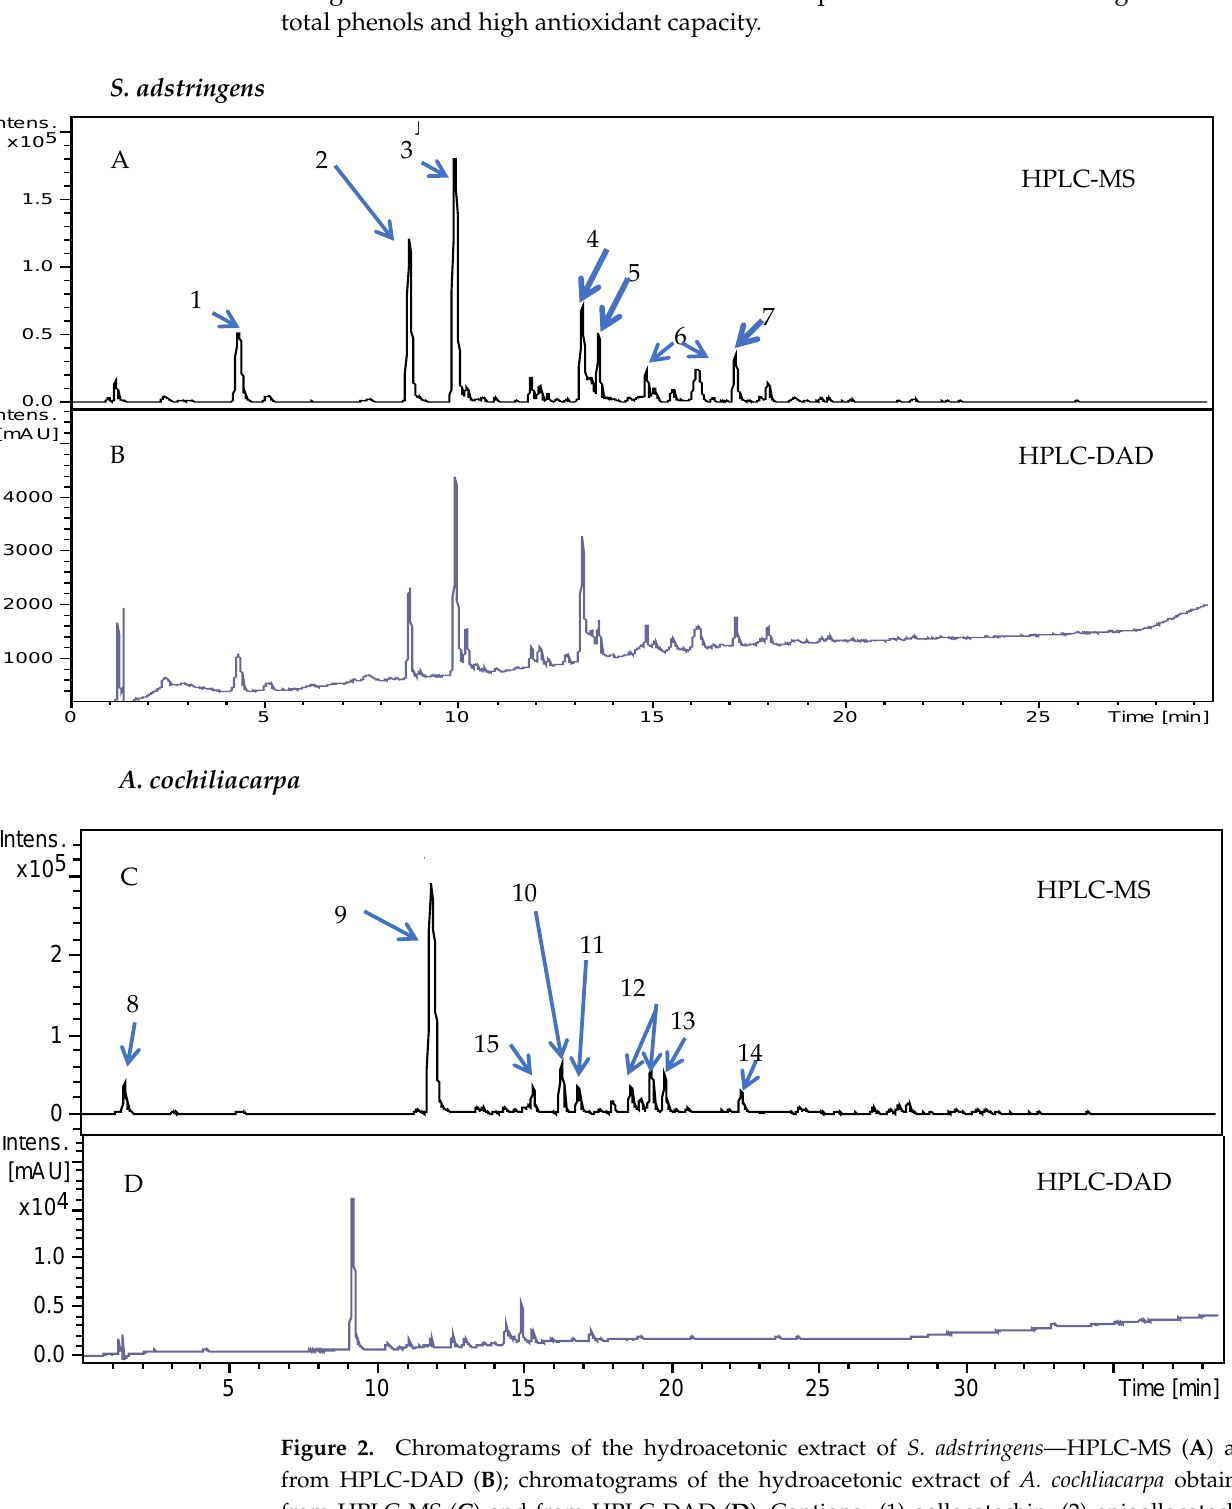
using the DPPH method and observed that the polar extracts showed a high content of total phenols and high antioxidant capacity.